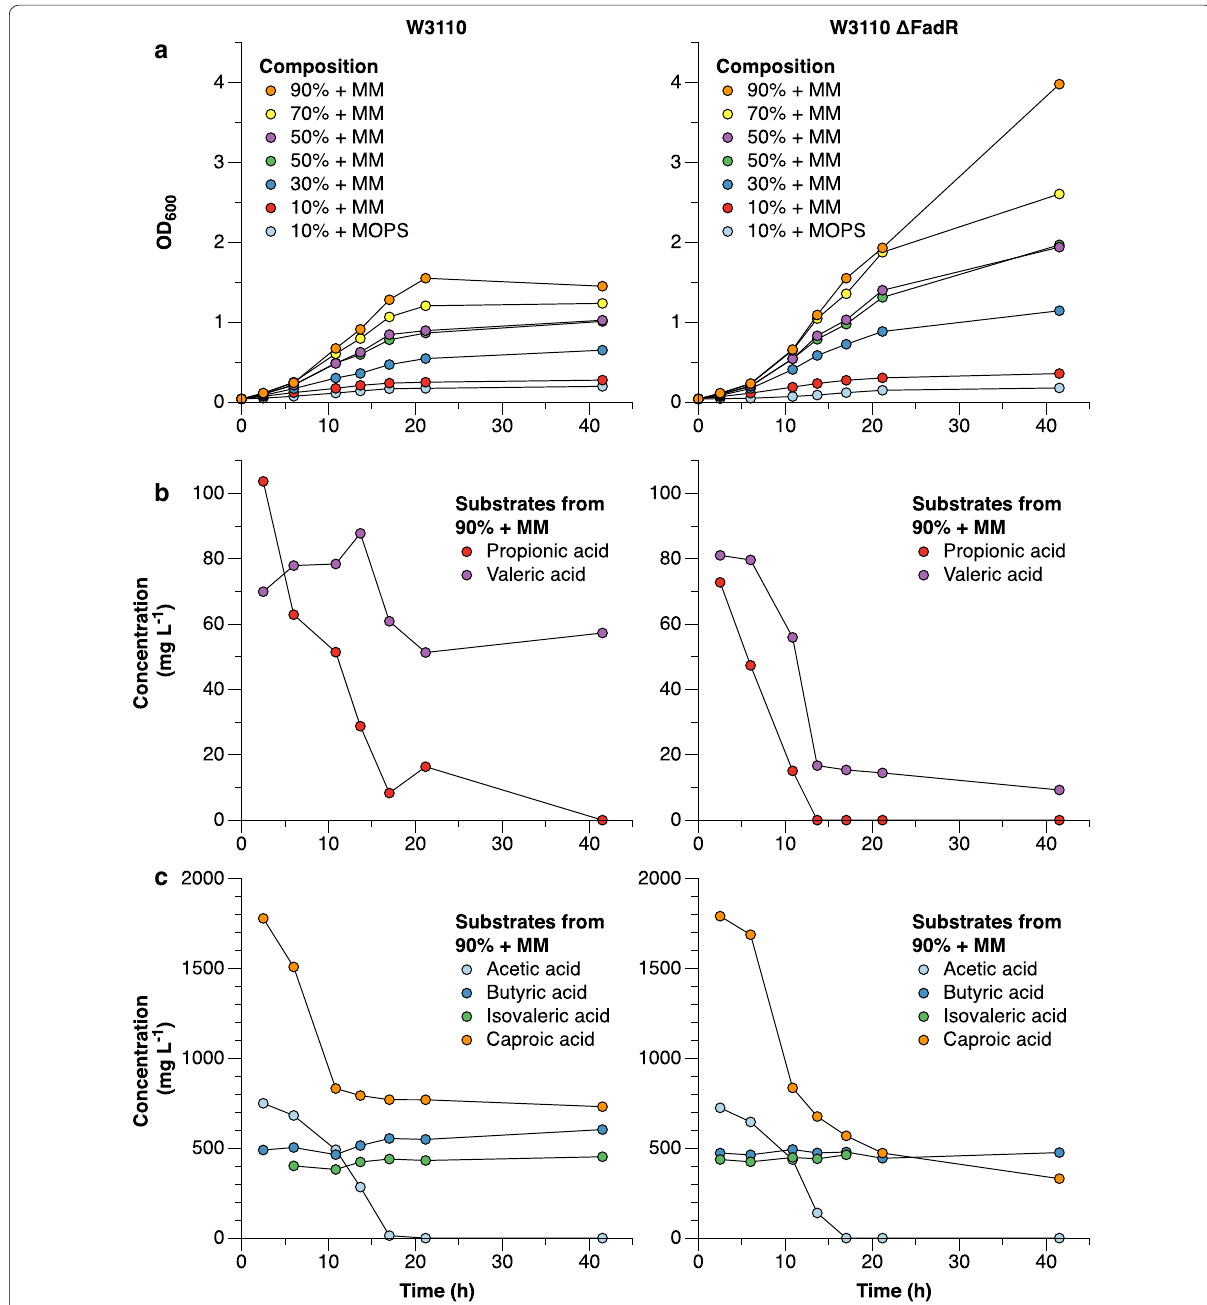
Fig. 1 Shake flask cultivation of E. coli W3110 (left) and W3110 ΔFadR (right) on a VFA-rich anaerobic digest of food residues supplemented with minimal medium salts (MM) at pH 7.0, 37 °C. To assess the tolerance of the strains, the anaerobic digest was supplied in concentration increments between 10–90% (v/v) diluted with water, with constant MM concentration. A replicate experiment was performed at 50% (v/v) digest concentration. a Growth curves for the two strains at various dilutions, supplemented with minimal salts medium ( b , c Residual acid concentrations in the medium supplemented with 90% anaerobic digest. The concentrations from each separate culture